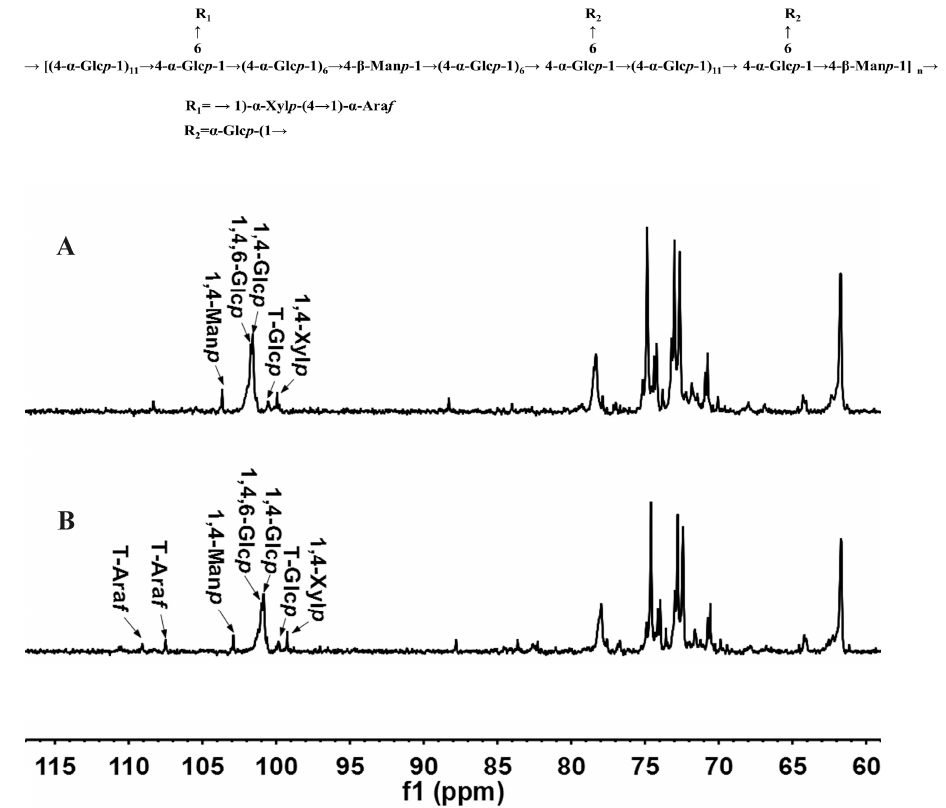
Figure 2. 13 C nuclear magnetic resonance (NMR) spectra of JCS1 polysaccharide and its degraded polysaccharide JCS10.1N. 13 C NMR spectrum of ( A ) JCS10.1N and ( B ) JCS1. Table 2. Proton ( 1 H) and 13 C nuclear magnetic resonance (NMR) spectral assignments for JCS1 (ppm).